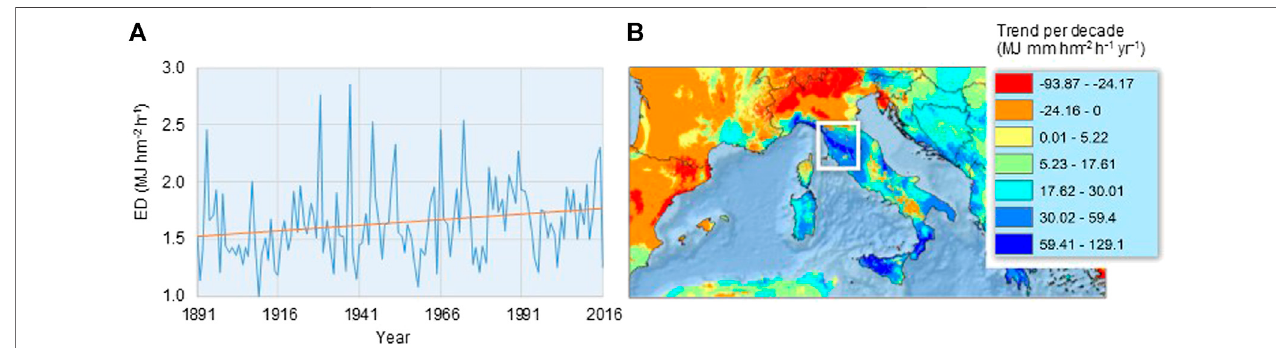
FIGURE 8 | Erosive susceptibility in the Arno River Basin and Tuscany (A) Annual evolution of erosivity density (MJ hm − 2 h − 1 ) from 1891 to 2016 across the Arno River Basin (blue curve) and the relative linear trend (orangeline), and (B) rainfall erosivity trend per decade (1961 – 2018), with the Tuscany region (where a positive trend of erosivity is detected) highlighted by the white square (derived from Bezak et al., 2020).